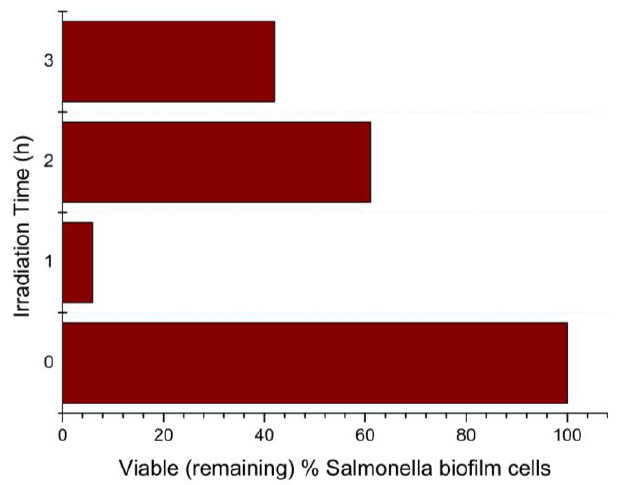
Figure 8. Percentage of remaining viable Salmonella Typhimurium biofilm cells after 1, 2, and 3 h of visible-light irradiation, with the presence of N-TiO 2 NPs.